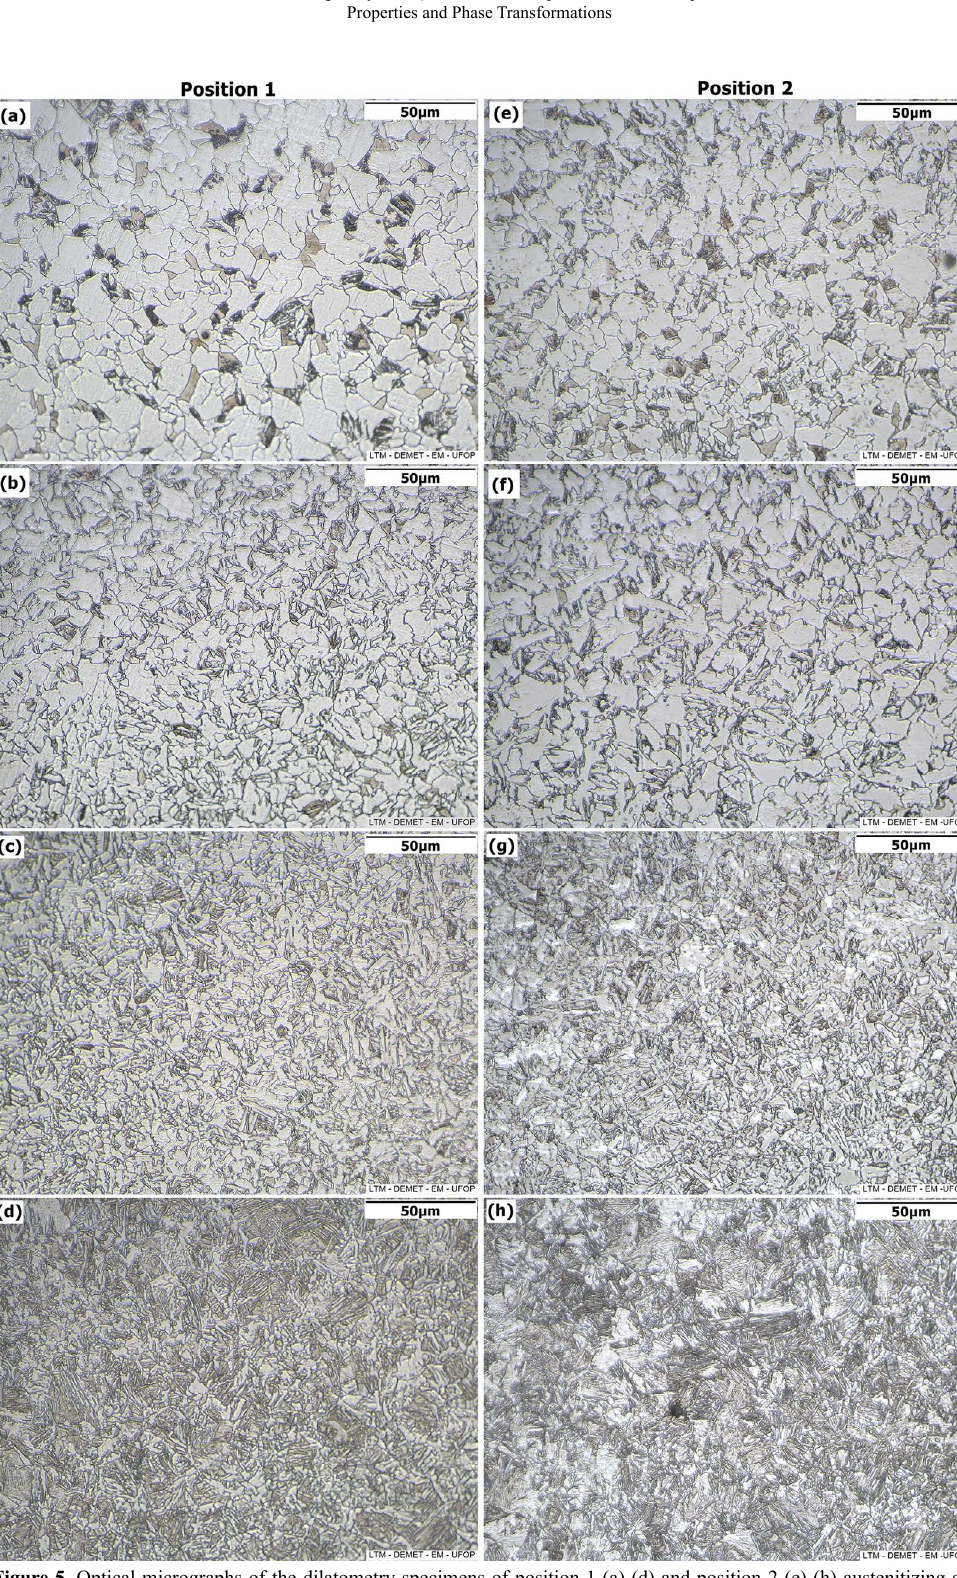
Figure 5. Optical micrographs of the dilatometry specimens of position 1 (a)-(d) and position 2 (e)-(h) austenitizing at 920°C and cooled to (a) and (e) 2°C/s (PF+P+P’); (b) and (f) 7°C/s (QF+GF+BF); (c) and (g) 20°C/s (GF+BF); (d) and (h) 100°C/s (B+M). C-Mn steel. Nital